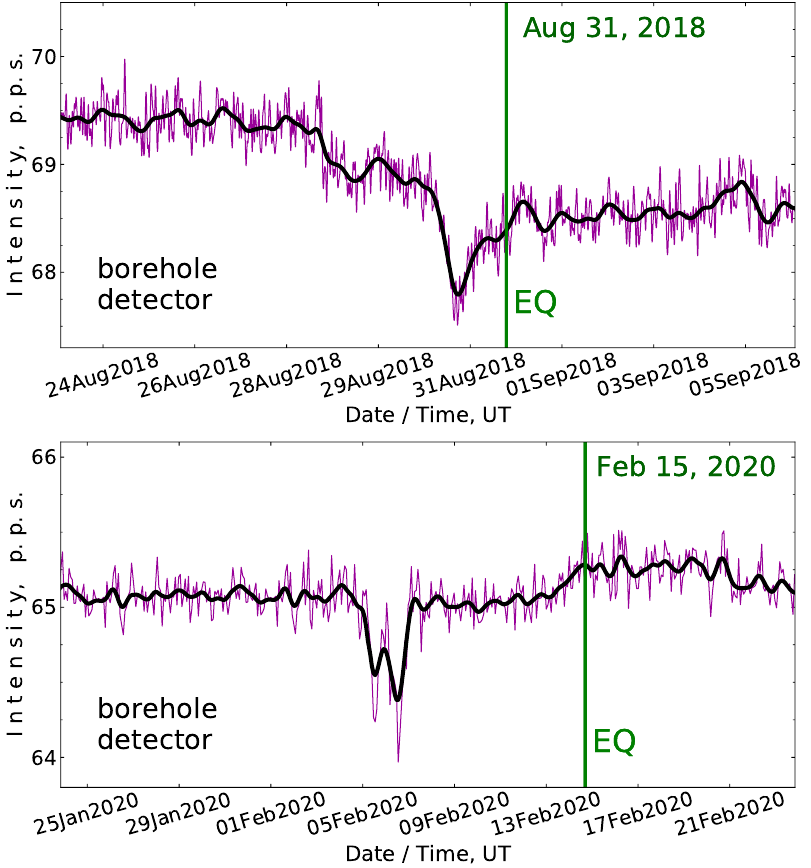
Figure 4. Examples of bay-like drops found in the smoothed records of gamma ray intensity before the earthquake events from Table1. Precise earthquake moments are marked with vertical